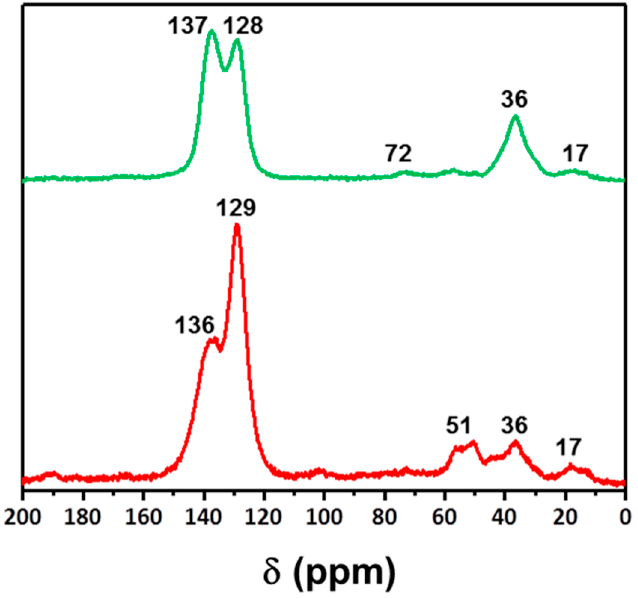
Figure 2. CP/MAS solid state 13 C NMR spectra of the dibenzyl ether (above) and triphenylmethanol (below) networks.